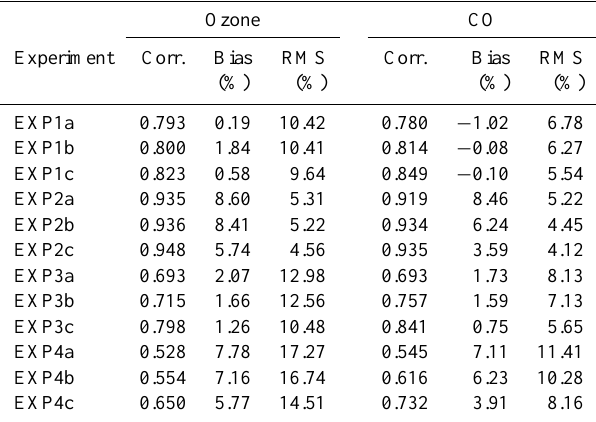
Table 4. Correlation, bias and RMS in % calculated for ozone and CO LmT column between the nature run and the control run (a), between the nature run and GEO-TIR2 assimilation run (b) and be- tween the nature run and the GEO-TIR assimilation run (c) for the 4 experiments averaged over 2 months (July and August 2009). Ozone